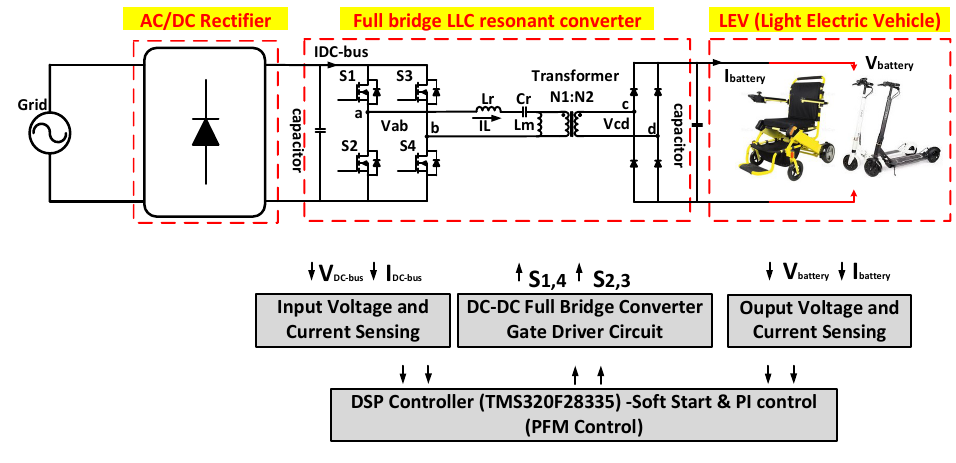
Figure 4. The fast charger for LEV.